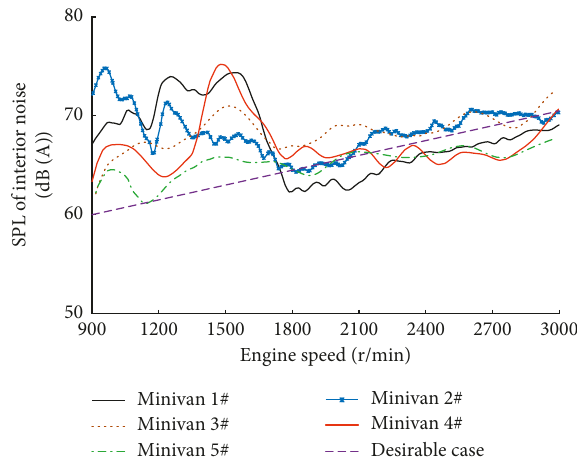
Figure 1: Interior noise during acceleration.